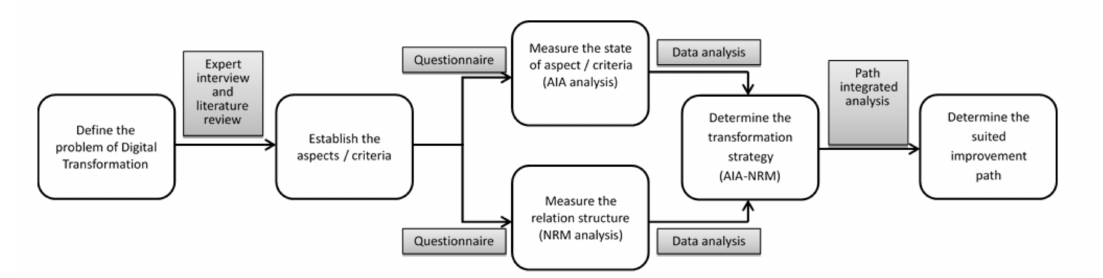
Figure 1. Research